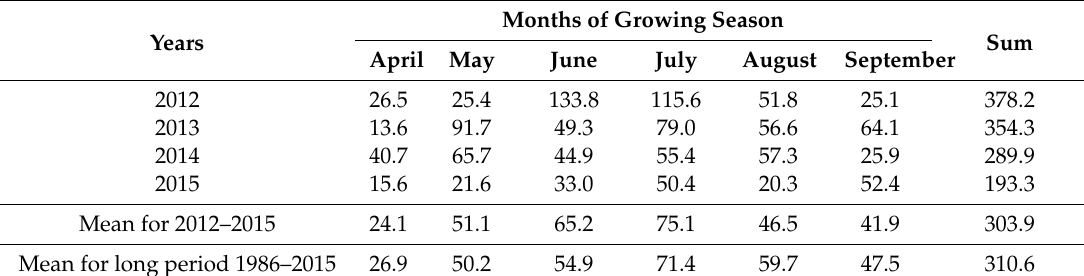
Table 3. Monthly amounts of rainfall (mm) data during the growing season of two watermelon cultivars: Bingo and Sugar Baby